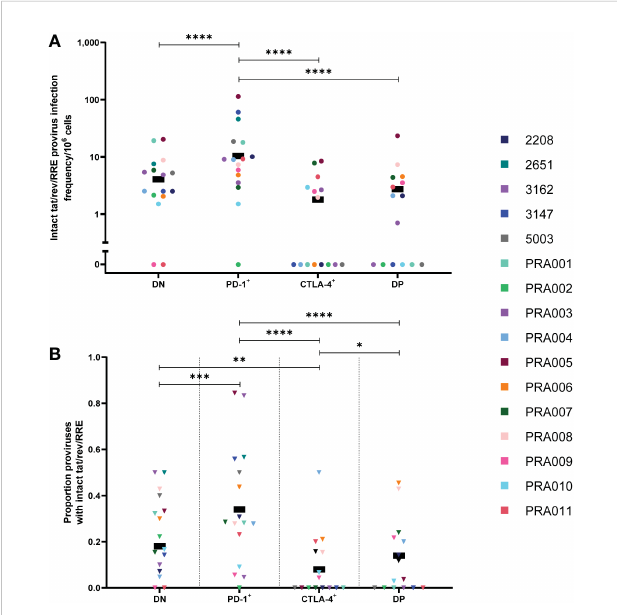
FIGURE 4 HIV-1 proviruses with an intact tat/rev/RRE + open reading frame in peripheral blood memory CD4 + T-cells expressing PD-1 and/or CTLA- 4. The HIV-1 infection frequency per 10 6 cells of proviruses with an intact tat/rev/RRE + ORF in DN, PD-1 + , CTLA-4 + and DP cells (A) . The proportion of ampli fi ed proviruses that contained an intact tat/rev/ RRE + ORF in DN, PD-1 + , CTLA-4 + and DP cells (B) . Data is the estimated infection frequency per 10 6 cells or proportion for each subset. p-values represent evidence for an overall trend of a difference between subsets within these participants, * p ≤ 0.05, ** p ≤ 0.01, *** p ≤ 0.001, **** p ≤